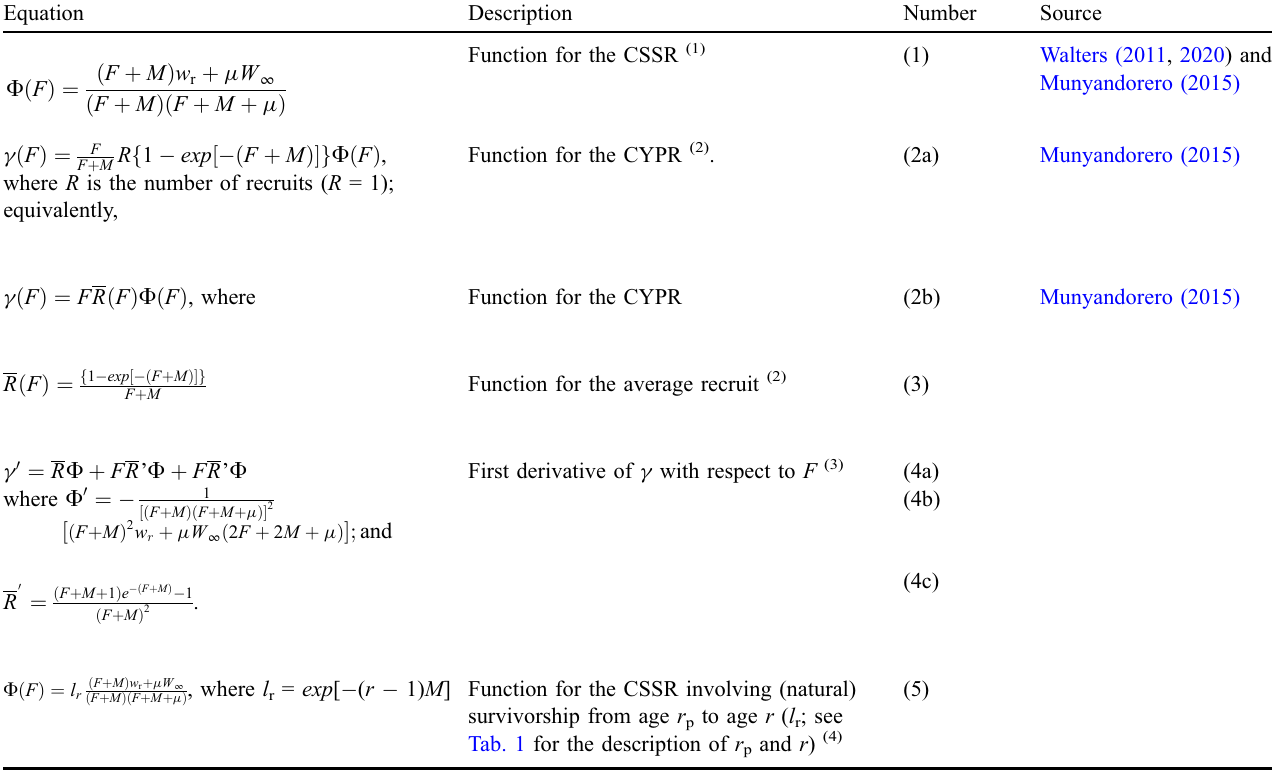
Table 2. The CYPR14 model (equations without source are developed in this study). Equation Description Function for the CSSR